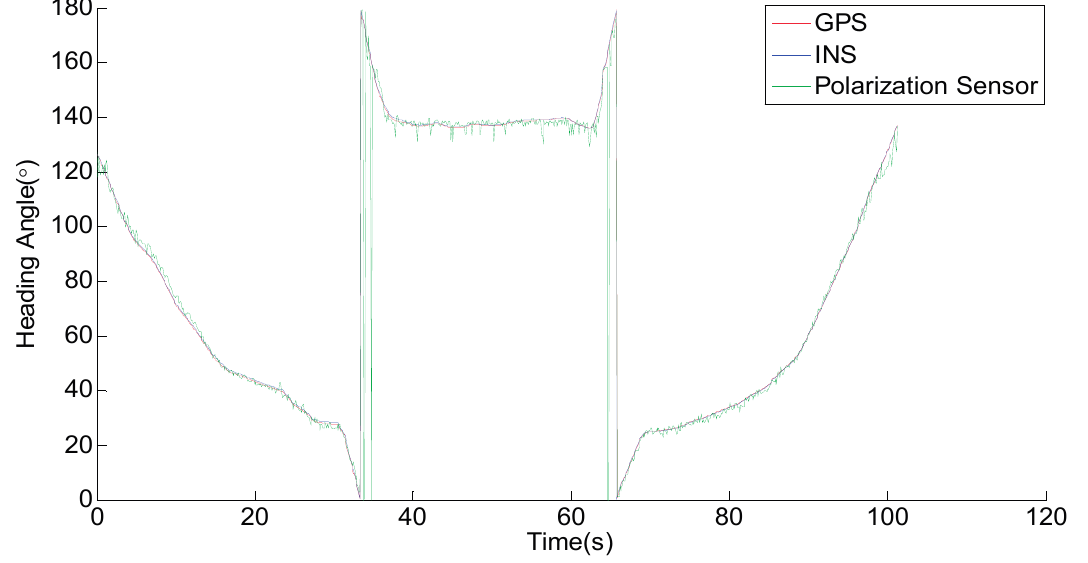
Figure 11. GPS, INS and the corrected result of the polarization sensor.